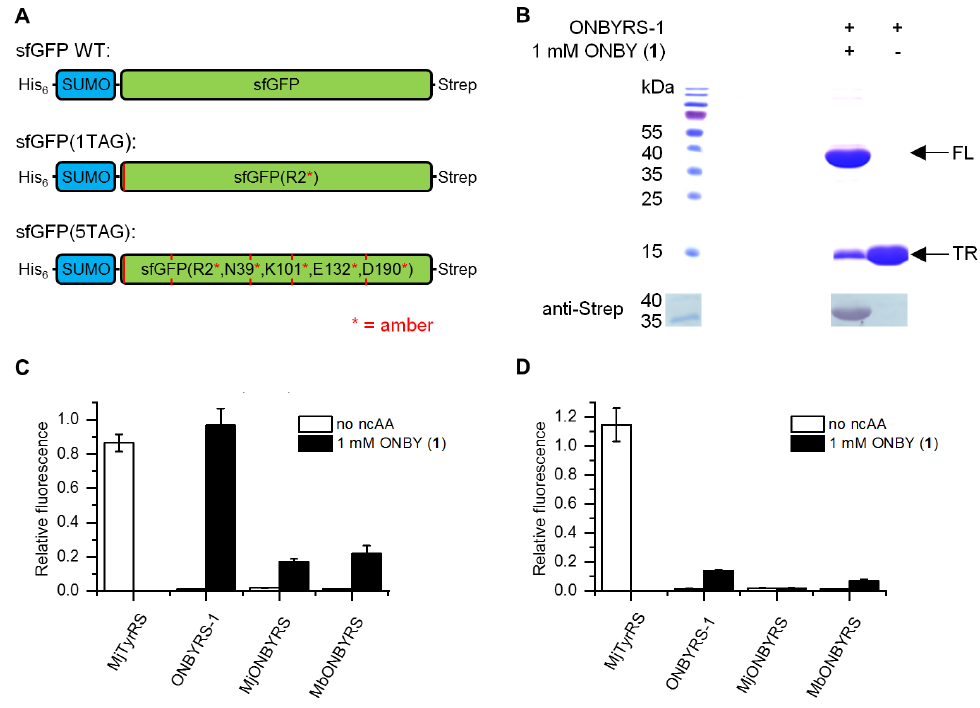
Figure 2. Characterization of ncAA incorporation by ONBYRS-1 into superfolder green fluorescent protein (sfGFP) reporter constructs and comparison with previously reported aaRSs (all expressed with corresponding tRNAs). ( A ) Schematic illustration of sfGFP reporter constructs for monitoring ncAA incorporation e ffi ciency at one or five positions in sfGFP. Relative positions of the in-frame amber stop codons are indicated (red lines, the sfGFP WT control construct is free of these). ( B ) SDS-PAGE and anti-Strep Western blot analysis of sfGFP(1TAG) expression. Proteins were produced in E. coli BL21(DE3) using ONBYRS-1 in the presence or absence of 1 mM ONBY as indicated (FL = full-length, TR = truncated product). ( C ) Fluorescence reporter measurements for the incorporation of ONBY into sfGFP(1TAG) using E. coli BL21(DE3) cells. ( D ) Fluorescence reporter measurements for the incorporation of ONBY into of sfGFP(5TAG) using E. coli C321. ∆ A.exp(DE3) cells. ( C , D ) Fluorescence values are normalized to strain-specific sfGFP WT fluorescence and to the OD 600 of the bacterial culture. In case of ncAA supplementation, 1 mM ONBY was used. Data represent mean ± s.d. of biological